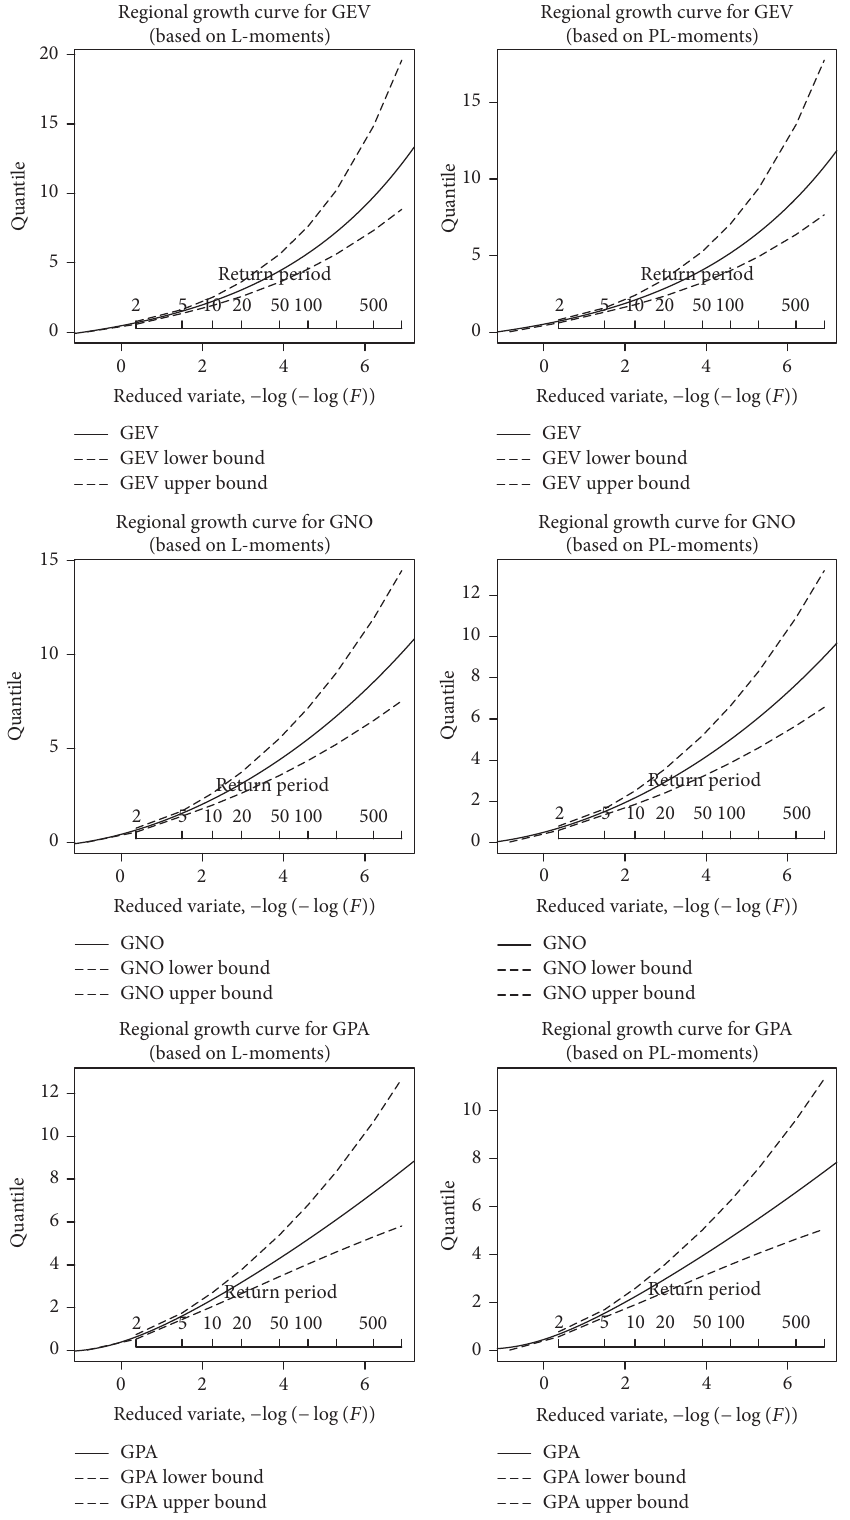
Figure 4: Regional growth curves of the three distributions for L-moments and PL-moments with their 90% error bounds for sample size of